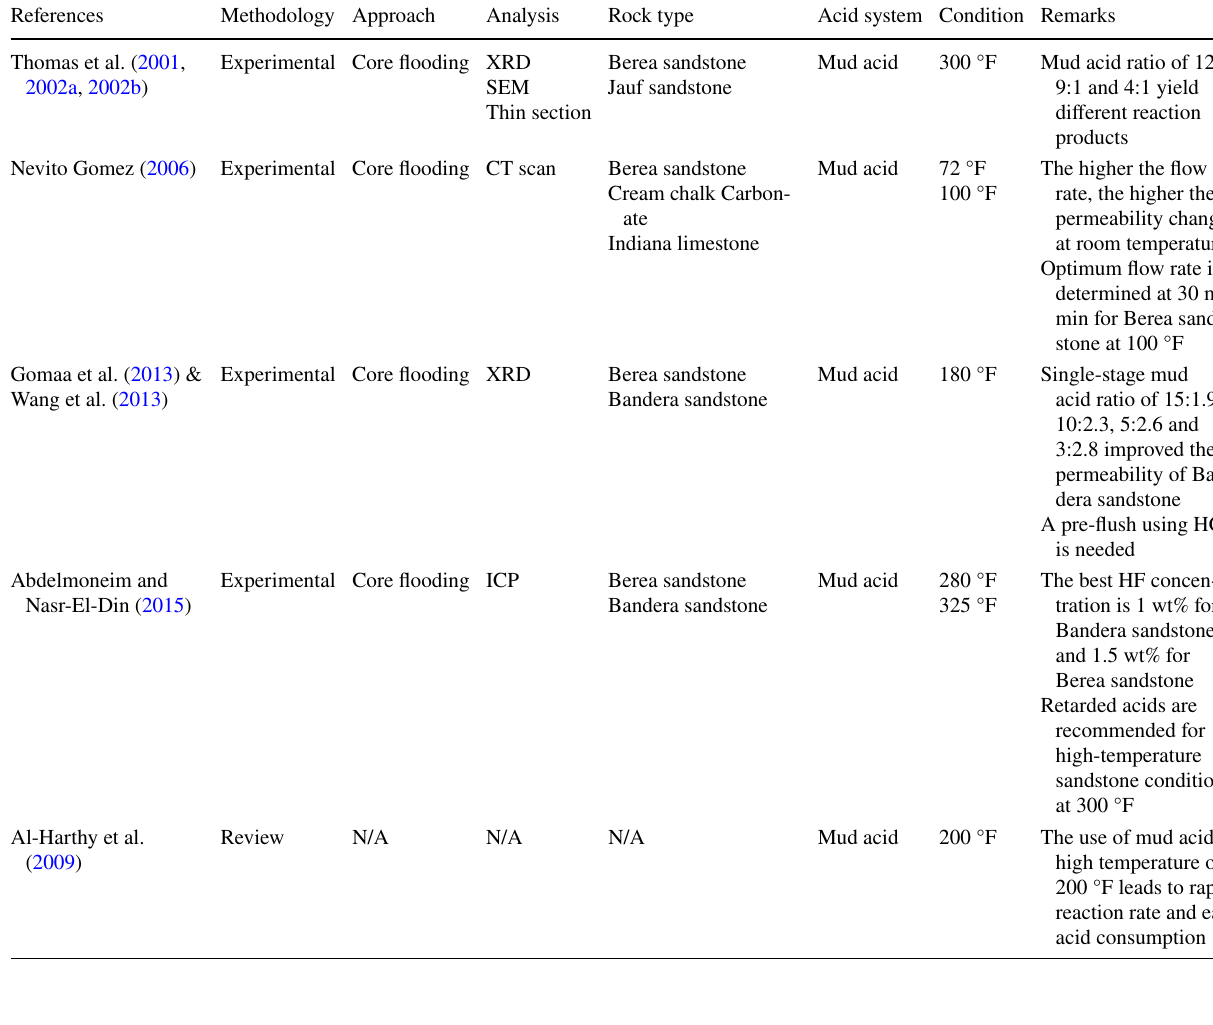
Table 7 Summarized interpretation of reviewed papers on mud acid used in matrix acidizing